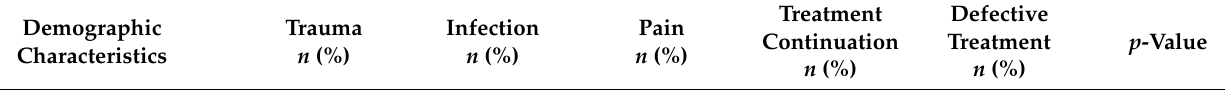
Table 3. Comparison between the demographic characteristics and purpose of the pediatric patient’s emergency visits before, during, and after the